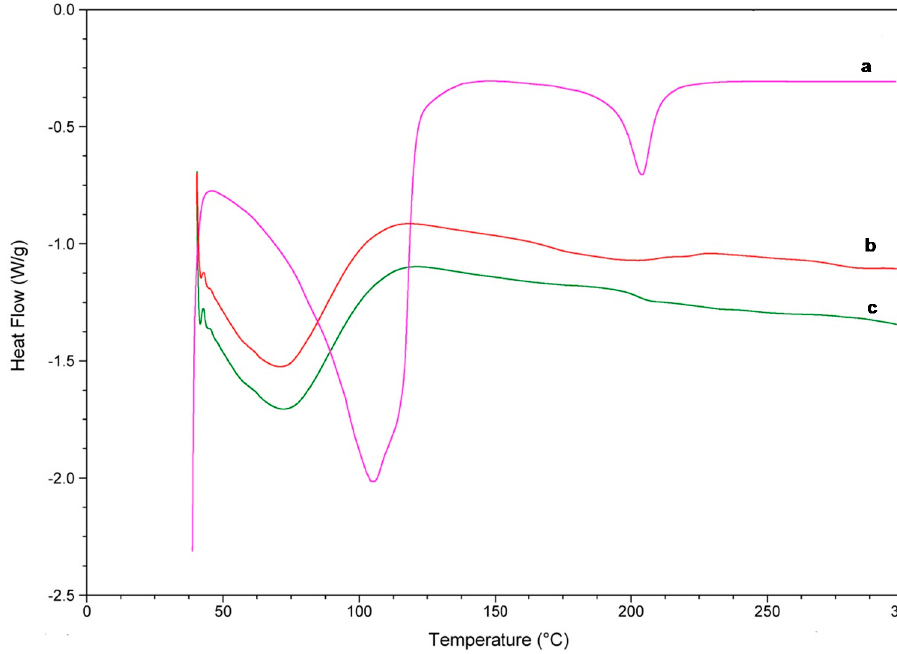
Figure 8. DSC curves of linalool ( a ), linalool-HP- β -CDs complexes by US ( b ), HP- β -CDs ( c ).